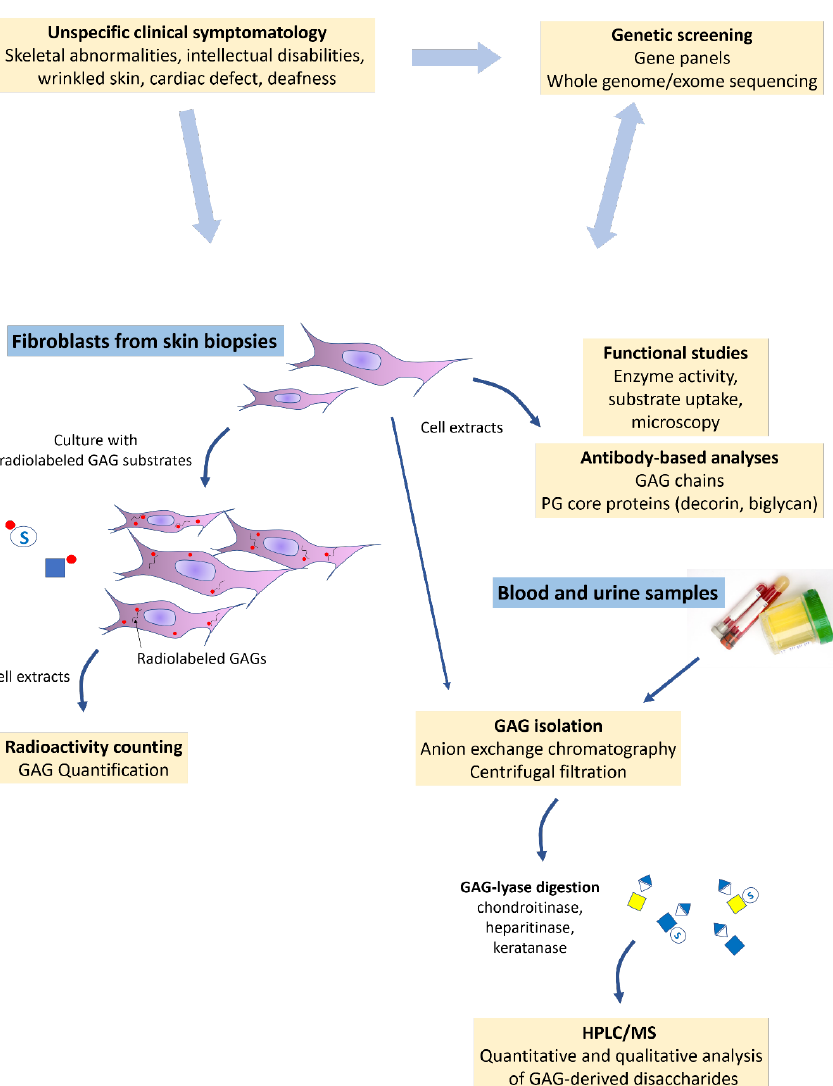
Figure 3. Schematic of current PG-IMD diagnosis strategy. Once PG defect is suspected clinically, genetic screening and GAG assessment are performed using patient’s samples. W hole genome/exome sequencing allows the identification of possibly pathogenic variants in PG metabolism-associated genes. Fibroblasts from skin biopsies are cultured with radio- labeled substrates and the measured radioactivity in cell extracts reflects PG biosynthesis capacities. Fibroblasts are also used for functional analyses measuring the activity of the suspected defective enzyme or transporter, while microscopy could detect protein mislocalization and/or abnormal Golgi morphology. Antibody-based techniques such as Western blot and flow cytometry are useful for highlighting impaired PG biosynthesis by targeting GAG chains or PG core proteins such as decorin and biglycan. As from blood and urine, GAGs could be assessed by analyzing purified and enzymatically released disaccharides using HPLC/MS. Altogether, these laboratory analyses either orient towards a genetic deficiency or confirm the causality of the suspected gene variant.